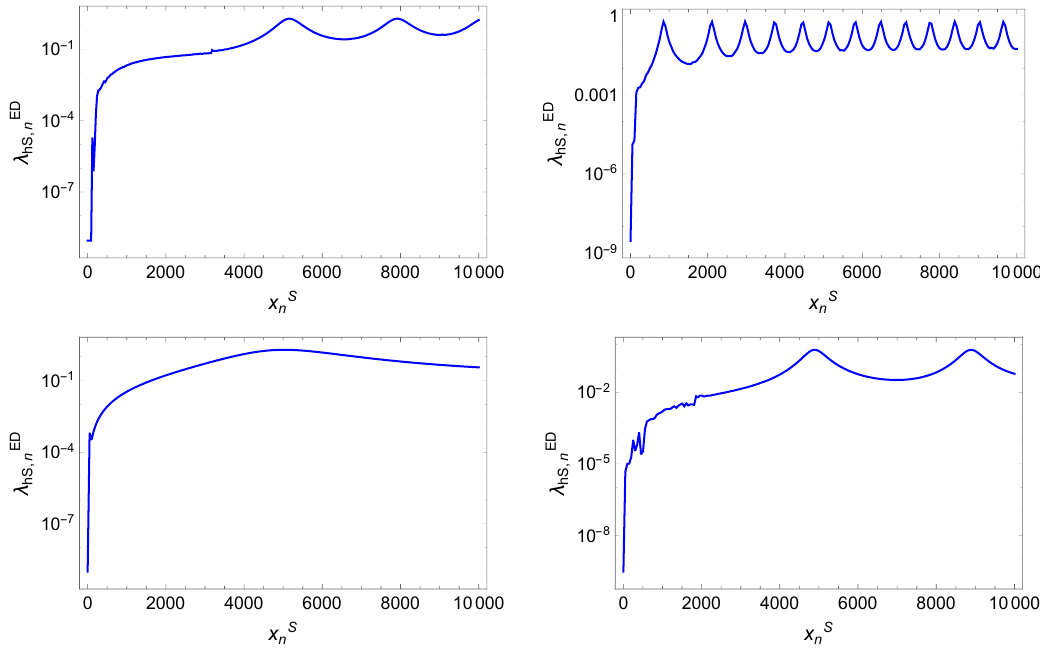
, for (cid:14) S = 10 (left) or (cid:14) T (cid:11) = 10 GeV (right), n